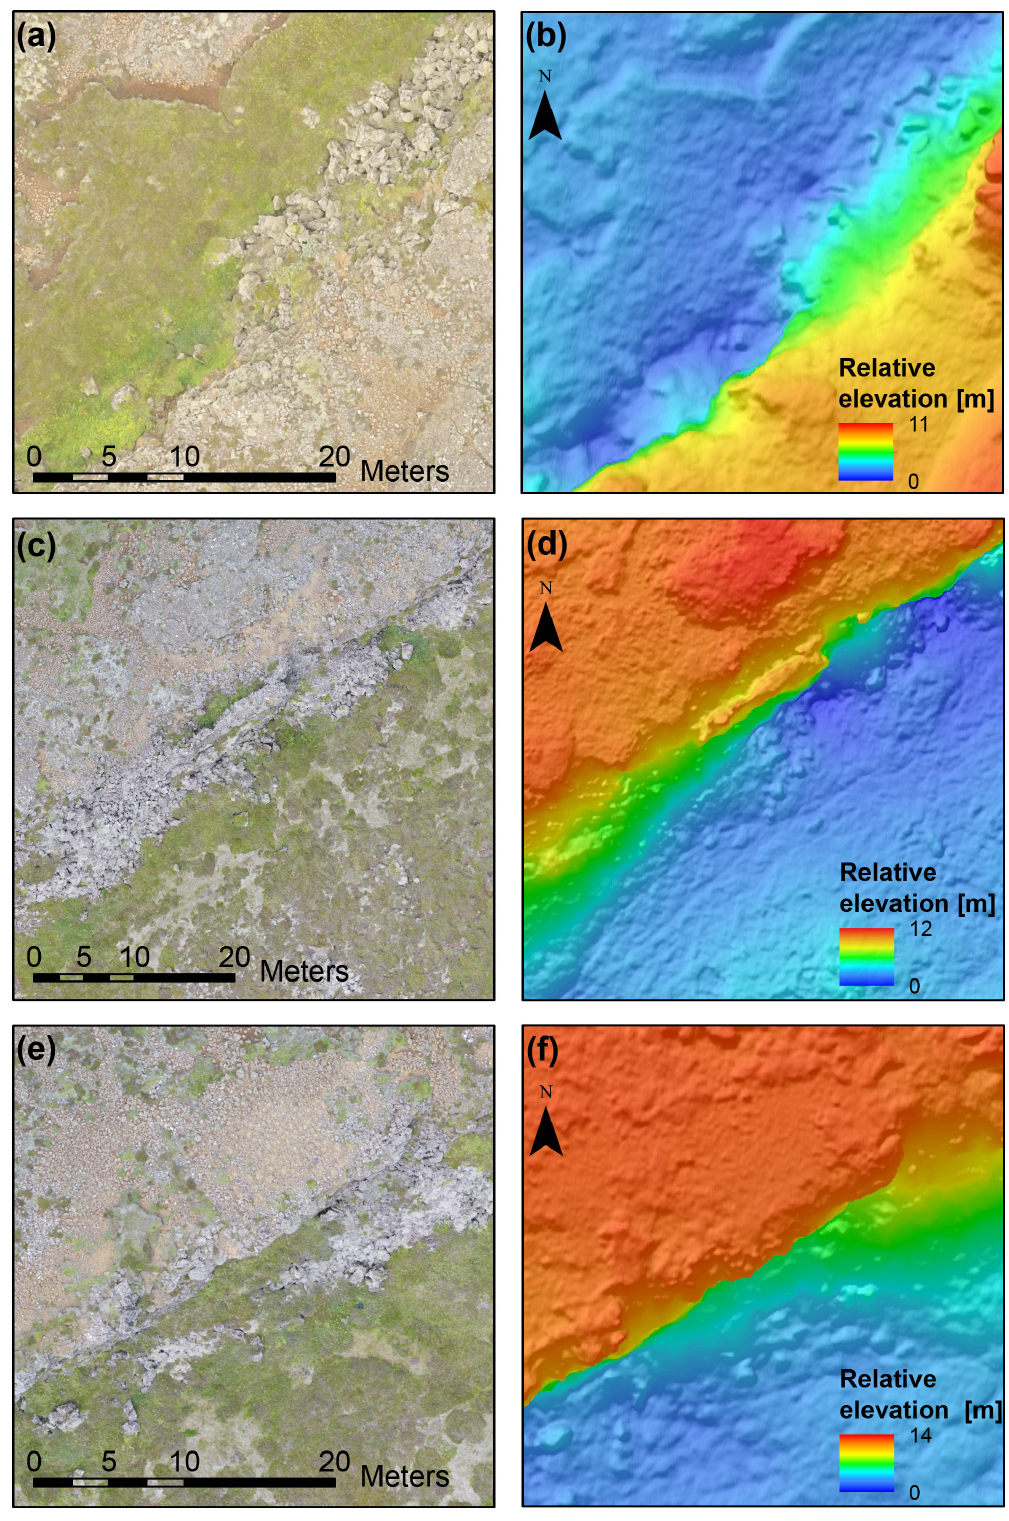
Figure 13. Samples showing the resolution of our DEMs and orthomosaics on dilatant faults with filled openings in Vogar: (a, c, e) orthorec- tified mosaics and (b, d, f) DEMs. (a, b) Vogar; the opening is still visible in the south but completely filled by basalt rubble in the north of the image; 63 ◦ 57 (cid:48) 30 (cid:48)(cid:48) N, 22 ◦ 21 (cid:48) 47 (cid:48)(cid:48) W. (c–f) Rubble and vegetation covering the openings; 63 ◦ 58 (cid:48) 11 (cid:48)(cid:48) N, 22 ◦ 20 (cid:48) 59 (cid:48)(cid:48) W, and 63 ◦ 58 (cid:48) 12 (cid:48)(cid:48) N, 22 ◦ 20 (cid:48) 52 (cid:48)(cid:48) W. Projection: WGS1984 UTM 27N and